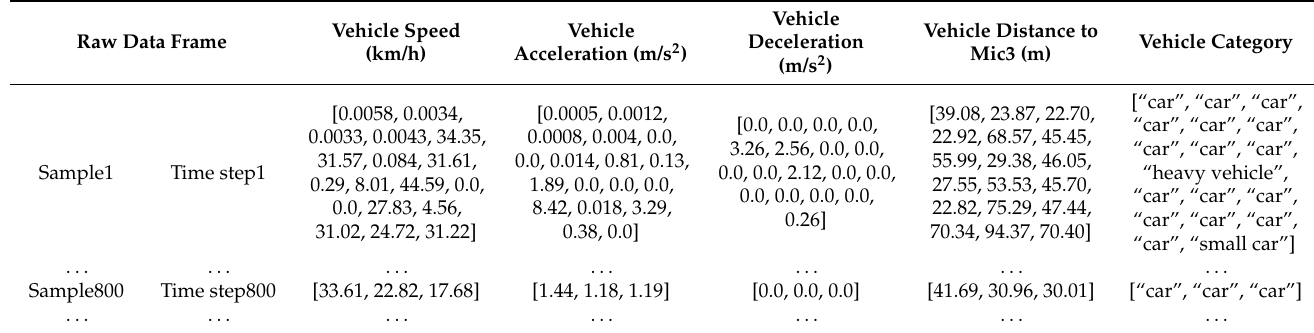
Table 3. Illustration of raw data frame reorganized in time order.